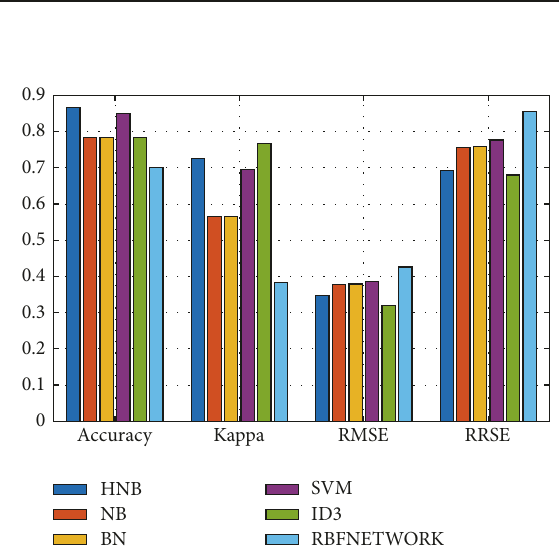
Figure 18: The statistical value of different